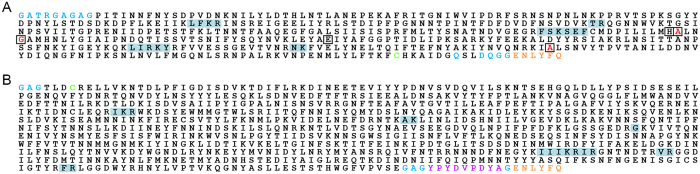
Proteomic characterization of BoNT/C1 ad heterodimer.(A) light chain sequence; (B) heavy chain sequence. Letters on white background represent confirmed sequence identified among one or more corresponding peptides from enzymatic digests of the recombinant protein. Letters on light blue background represent sequences not recovered from any of the digests. Blue letters represent exogenous linkers/spacers introduced into the recombinant protein. Boxed letters in Panel A mark positions of five non-adjacent amino acids – H, E, H, E, Y – that form the active site of Zn2+-metalloprotease; red letters among this group represent mutations E238 > A; H241 > G; Y383 > A introduced into the metalloprotease active site rendering it inactive in this atoxic derivative. Orange letters represent the TEV protease recognition sequence. Green letters represent the two cysteine residues that form the disulfide bridge between light and heavy chains of the heterodimer. Magenta letters (Panel B) represent the HA tag introduced at the C-terminus of the heavy chain for detection purposes.